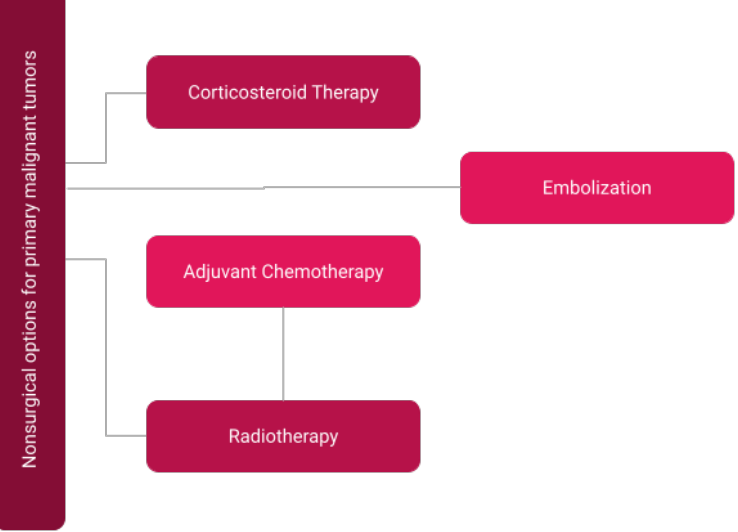
Figure 4. Overview of non-surgical considerations for primary malignant tumors in patients.